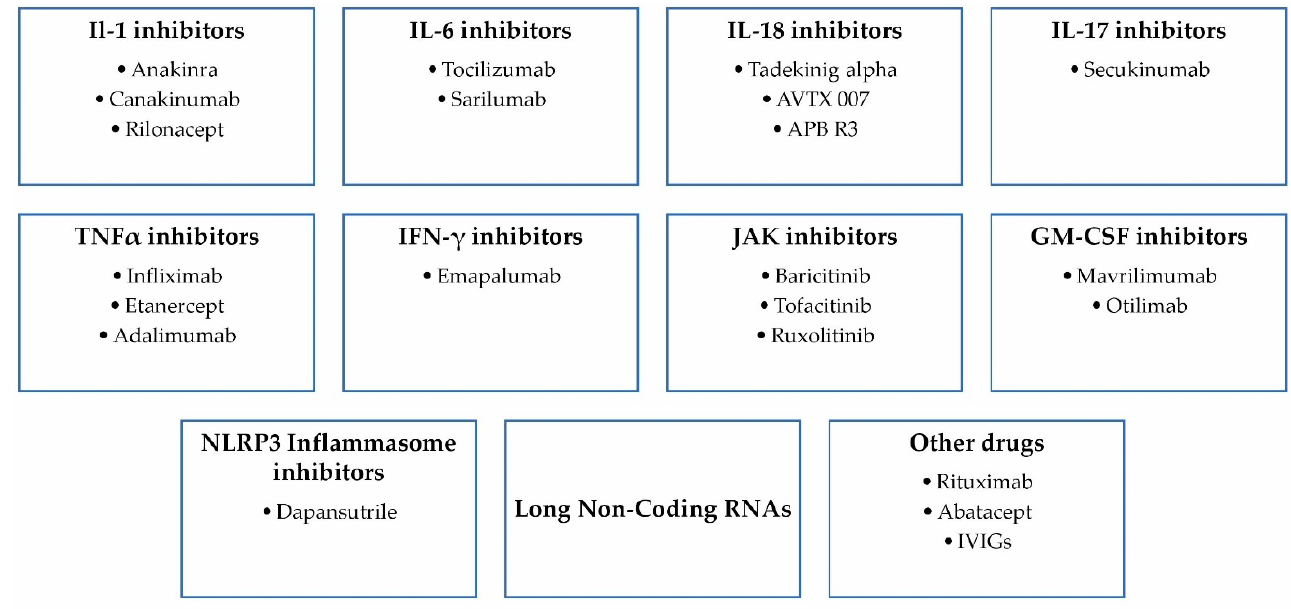
Figure 5. Anti-cytokine therapy in AOSD.